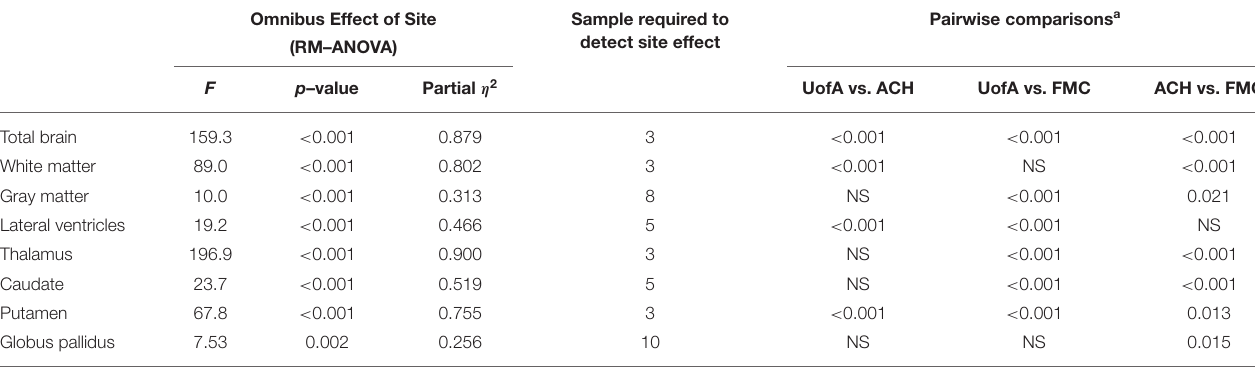
TABLE 3 | Repeated measures ANOVA effects of site on traveling phantom